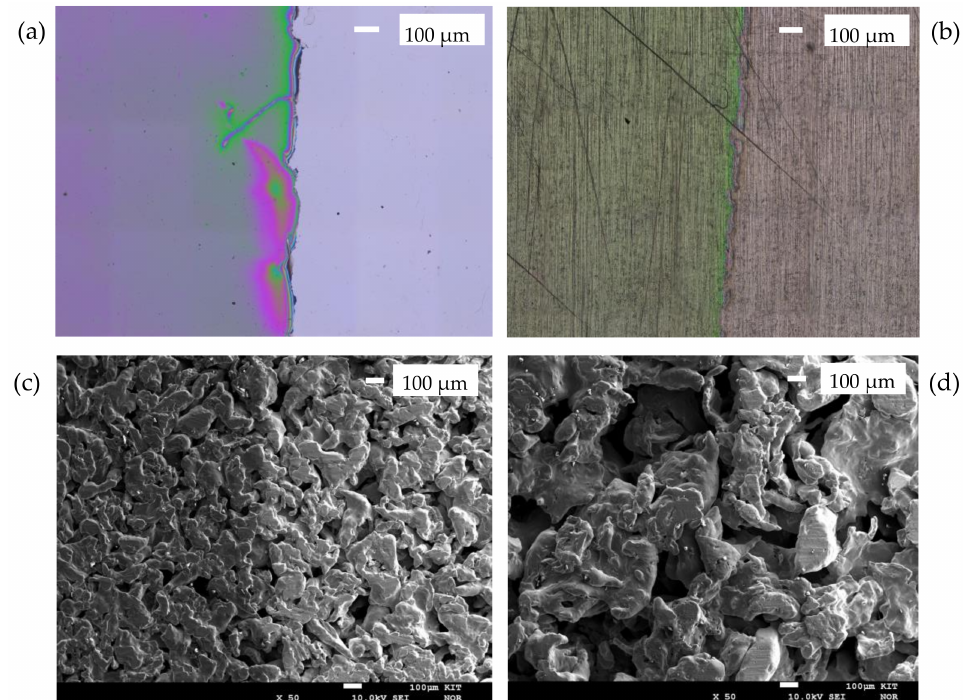
Figure 4. Top view of the coatings on different substrates (left hand side: coated; right hand side: uncoated. ( a ) Si-DLC on silicon substrate—optical profilometry 10 × ; ( b ) Si-DLC on SS-flat substrate— optical profilometry 10 × ; ( c ) Si-DLC on SS-40% porous substrate-SEM; ( d ) Si-DLC on SS-52% porous substrate-SEM.